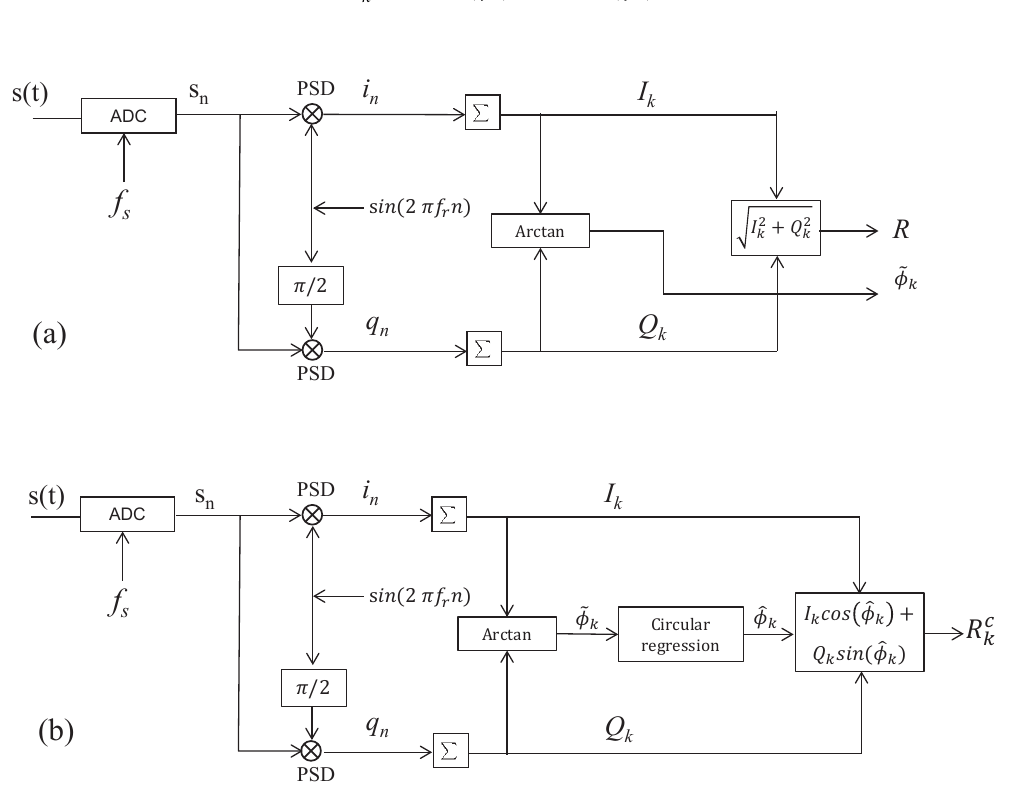
Figure 2. ( a ) Basic dual-phase lock-in amplification (LIA); ( b ) Linear-Circular regression-based dual-phase LIA. ADC: analog-digital convertor. ∑ : sum function working as low-pass filter. Arctan: the inverse tangent